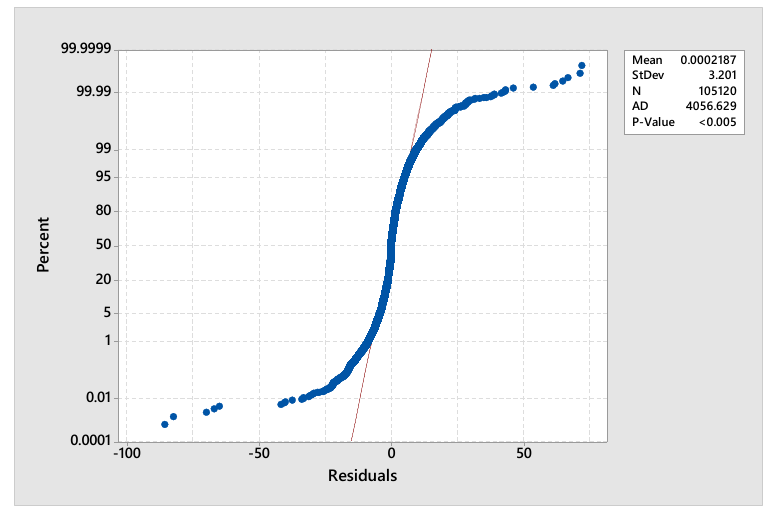
Figure 2. The Q–Q plot to check for normality of the noise for the wind farm. Thus, we have to transform the errors to the standard normal distribution. To do so, define the combined collection of errors as the random variable Y . Note that in reality there is a random variable for each time t , but for the wind farm we are assuming that the distributions for each time are similar so we can group all the errors together as coming from the same distribution. This assumption follows from the lack of seasonality in the wind farm output. Then for the error at each time t , find the probability p = P ( Y ≤ y t ) . Then, transform each y t by finding z t = F − 1 ( p ) where F ( z ) is the cumulative distribution function of the standard normal distribution Z . The usual procedure then is to square the z t and construct a forecast for the variance using either an ARCH or GARCH model, whichever is appropriate. However, as found in [6], an exponential smoothing forecast model is an efficient alternative. For the estimate of the variance at time t , S t , we have